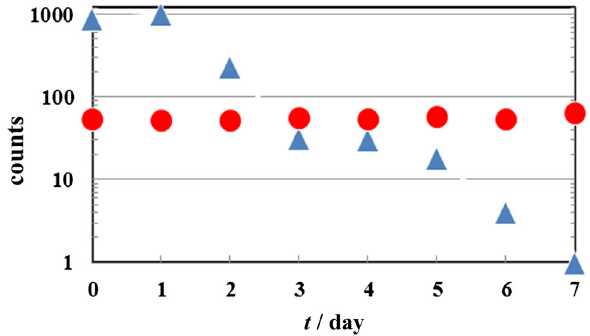
Fig. 5 Number of the coliform bacteria determined during the purification test using artificial seawater with living tropical fishes ( red circles ), and that determined using the waste seawater collected after the ‘‘living’’ experiment ( blue triangles